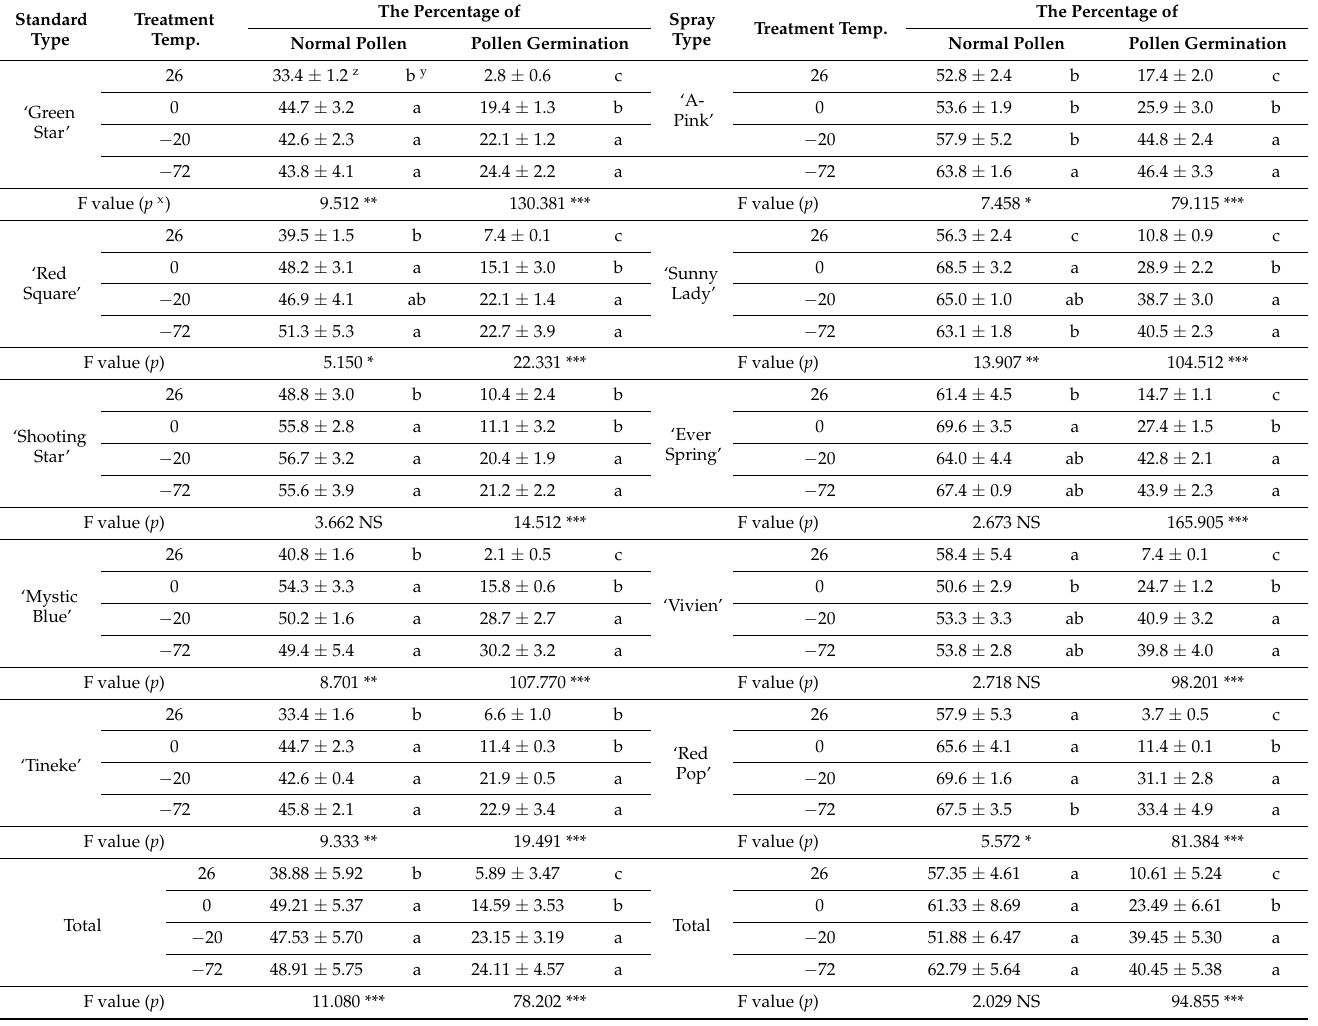
Table 3. Effect of storage temperature on normal pollen rate and germination rate for five standard and spray cultivars at 26, 0, − 20, and − 72 ◦ C after 30 days of